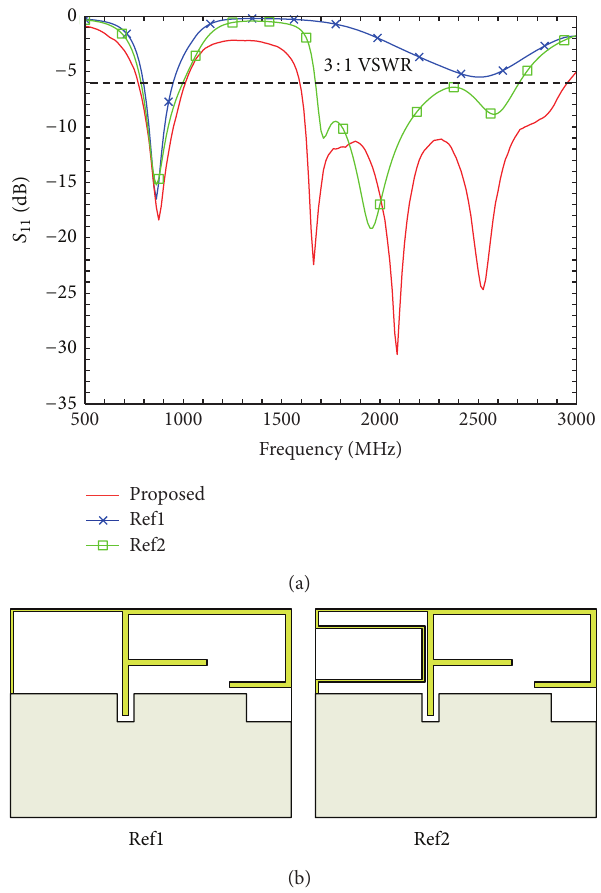
Figure 2: (a) Comparison of the simulated 𝑆 11 . (b) Corresponding antenna with a simple shorting strip (Ref1) and the corresponding antenna with a meander shorting strip (Ref2).